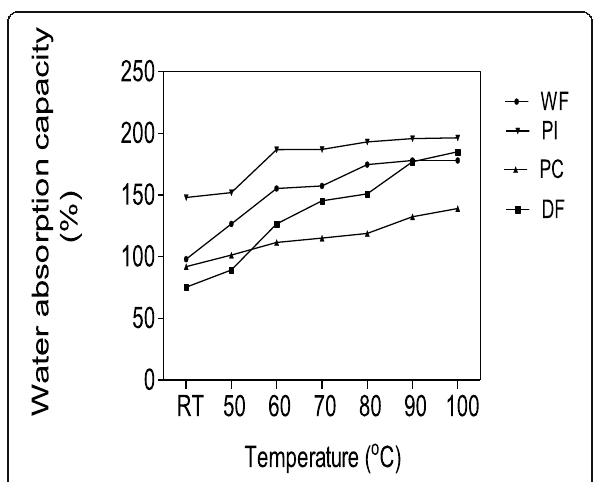
Fig. 2 Effect of temperature on water absorption capacity whole flour, defatted flour, protein concentrate and